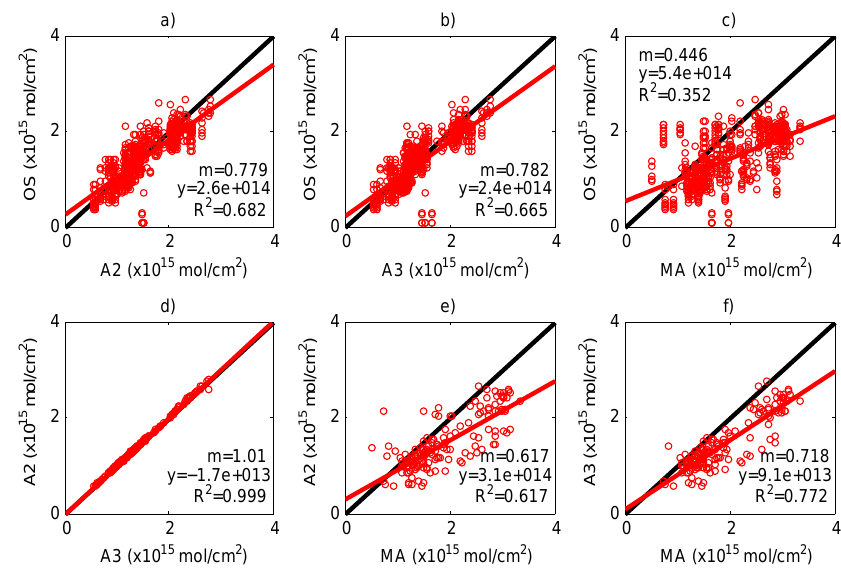
Fig. 11. As for Fig. 6, satellite 17–40km NO 2 partial